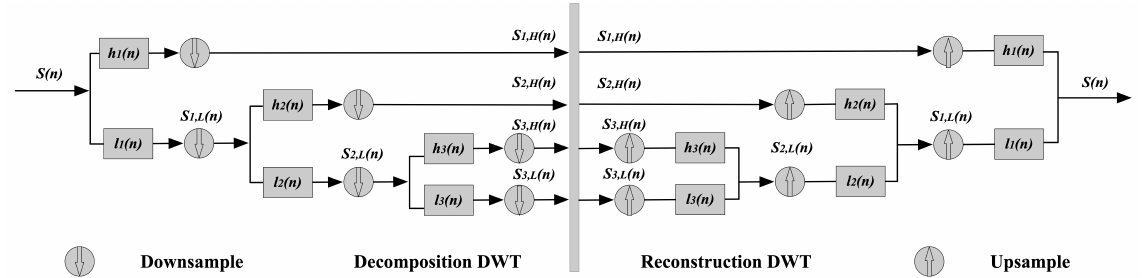
Figure 4. A schematic diagram of the decomposition and reconstruction process of the three-layer wavelet